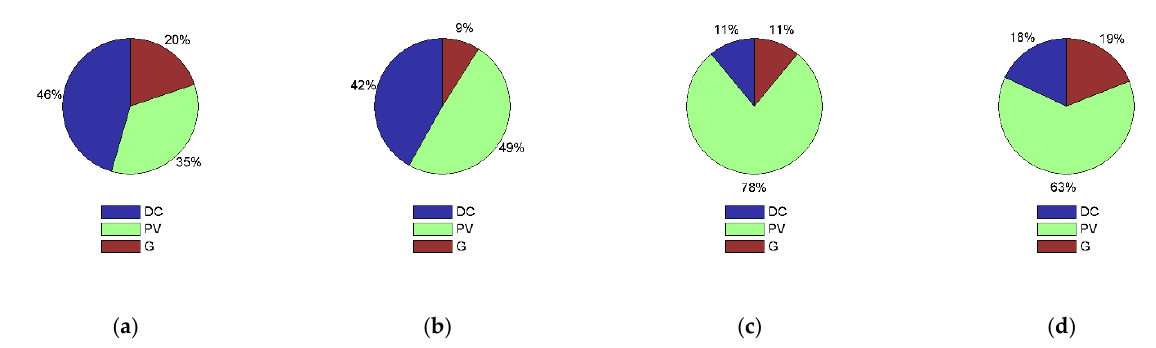
Figure 19. Seasonal thermal demand satisfaction divided by energy sources: ( a ) RBC; ( b ) MPC with OF G ; ( c ) MPC with OF C ; ( d ) MPC with OF P . Results obtained with a PH of 18 h.